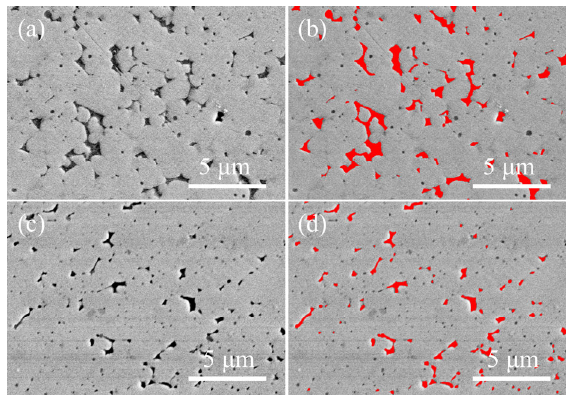
Fig. 7 SEM images and corresponding Co content analyses of the as-sintered samples: (a, b) HC1550-L, (c, d) HC1550-H. Co is highlighted in red.